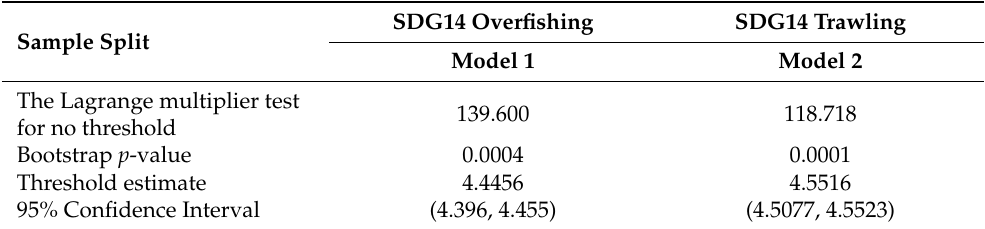
Table 4. Threshold estimates of using different threshold variables.